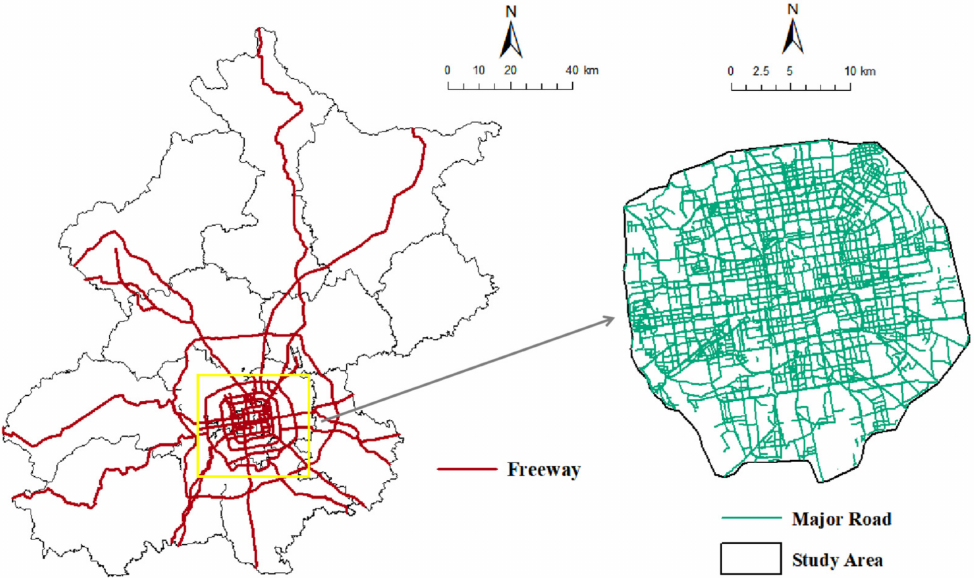
Figure 1. Roads and streets within the Fifth Ring Road in Beijing. The yellow square refers to the area within the Fifth Ring Road of